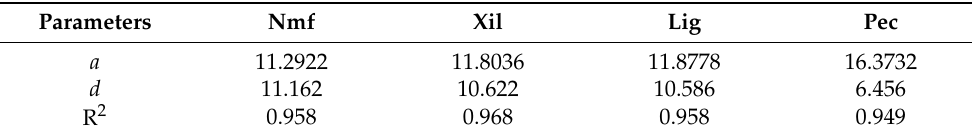
Table 4. Parameters of the exponential decay model for RB5 dye removal by nonmodified fiber (Nmf) and fibers treated with xilanase (Xil), ligninase (Lig), and pectinase (Pec).